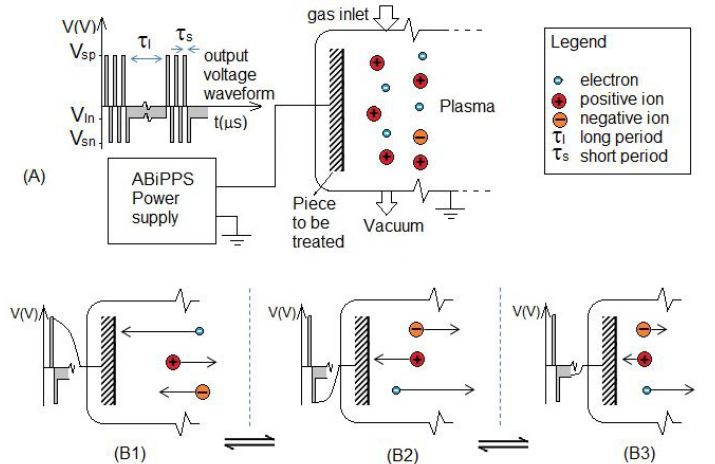
Figure 1. (A) Voltage waveform provided by ABiPPS power supply connected to the samples during the plasma oxidation. (B) forces experienced by electrons and ions in different point-in-time on voltage waveform graphics: (B1) high positive voltage, so negative charge carriers (electrons and negative ions) are accelerated toward the electrode (samples); (B2) negative high voltage, so positive ions are accelerated toward the electrode; (B3) lower negative voltage (during longer time), so positive ions hit the electrode with mild mean energy.